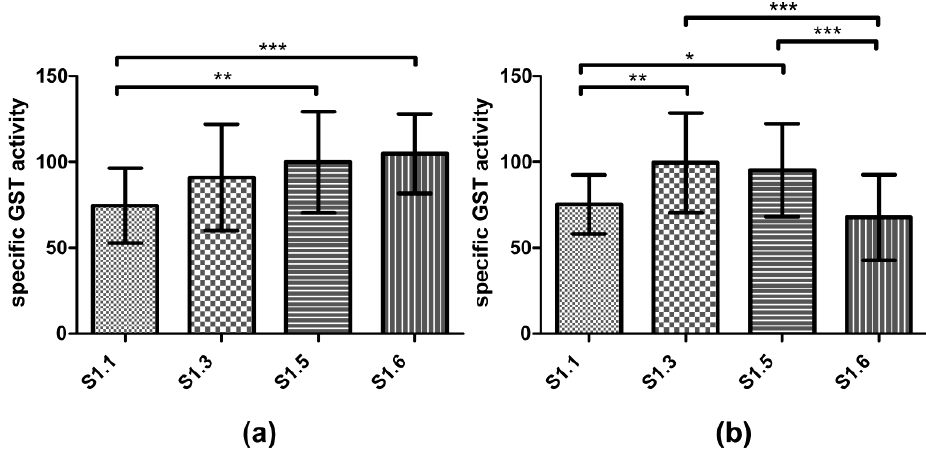
Figure 3. Specific glutathione S-transferase (GST) activity was measured in earthworms exposed to the first set of substrates for 48 h ( a ) and 14 days ( b ). Significant differences between substrates (ANOVA followed by Tukey) are labeled with * ( p < 0.05), ** ( p <0.01), and *** ( p < 0.001). Biomarker responses showed that in all three measured biomarkers, significant dif- ferences between substrates were determined. Already 48 h after exposure to tested sub- strates, the differences in measured activities were observed indicating that, in addition to the behavioral changes in terms of preferences for certain substrates, components of the substrates could have effects also on a biochemical level. 4. Discussion The success of vermicomposting is significantly influenced by the type of substrate added to the process [33]. In this sense, before the vermicomposting process, it is im- portant to carry out certain tests with selected substrates. In this way, it is possible to choose components that will be most adequate for this process. Selection of the most ade- quate substrate will result in the optimal processing of material and obtaining a product of high value. In the present study, three substrate sets, each comprising six substrates with differ- ent compositions, were tested to assess their effects on the earthworm Eisenia andrei . In the first set, the substrates were first subjected to composting (days spent in the thermophilic phase are given in Table 1). After that, earthworms were placed in the obtained substrates and two substrates proved to be completely unsuitable for vermicomposting, as substan- tial mortality was observed already after 48 h of exposure (substrates S1.2 and S1.4). In other substrates, survival was 100 %, which enabled further behavioral and biomarker testing. Regarding the mortality in mixtures of leaves, horse manure, microorganisms and urea (S1.2), leaves, microorganisms, urea, and wood chips (S1.4), it is possible that the addition of microorganisms caused unfavorable conditions and, consequently, led to the mortality of earthworms. There is also a possibility that the urea was not sufficiently bal- anced in the mixture, which may be the cause of mortality of earthworms in these sub- strate combinations. The remaining substrates (S1.1, S1.3, S1.5, and S1.6) were further tested in an avoidance test. Namely, the avoidance test is based on the fact that organisms have the ability to avoid unfavorable conditions. This test is quick, cost-effective, ecologi- cally relevant, and has a high sensitivity. Avoidance behavior by earthworms has been recognized as a valuable endpoint in soil quality assessment [34 , 35]. In the avoidance test, earthworms showed a clear preference for the S1.1 substrate, indicating this substrate to be most favorable for earthworms. Obviously, the combination of horse manure and leaves (components of the S1.1 substrate) is the most adequate for the earthworms. Com-